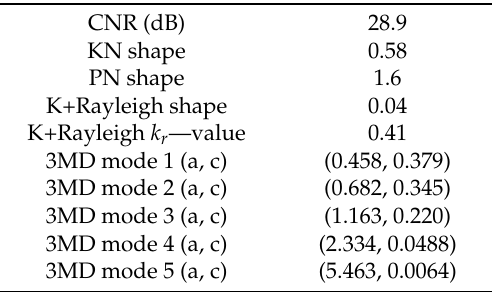
Table 4. Parameter estimates for the models in Figure 7.